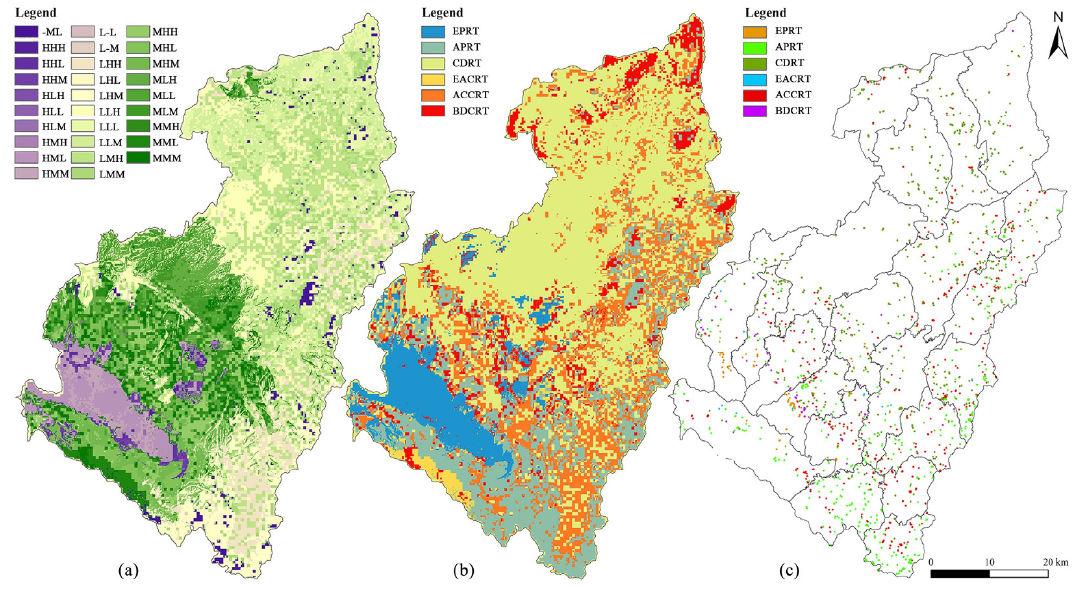
Figure 9. The spatial analysis of the idle residential renovation types: ( a ) the spatial coupling analysis of suitability; ( b ) the spatial analysis of renovation types; ( c ) the spatial distribution diagram of the idle residential renovation types.